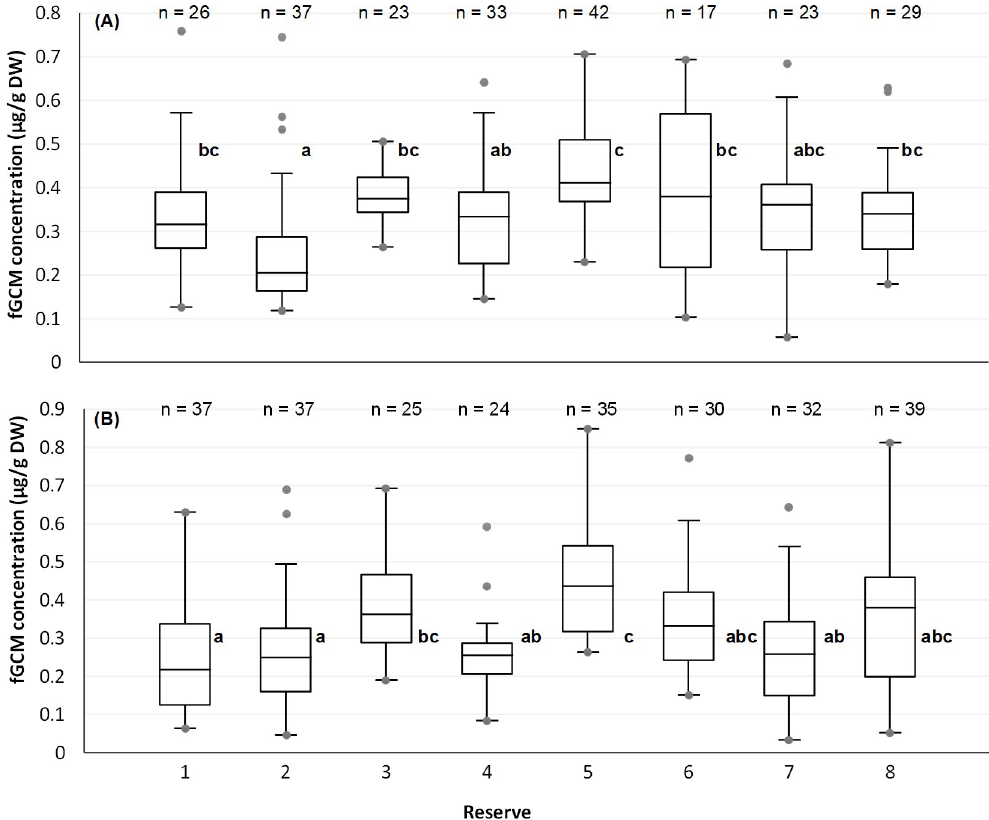
Fig 2. Influence of reserve on the faecal glucocorticoid metabolite (fGCM) concentration ( μ g/g DW) collected for (A) Female, and (B) Male elephants from eight reserves between March 2019 and January 2021. Different letters indicate significant differences between elephants of respective reserves (based on mean ranks, a = reserve with the lowest mean rank). The graph represents the minimum, 1st quartile, median, and 3rd quartile, together with both the limits (the ends of the "whiskers") beyond which values are considered anomalous. The limits were calculated as follows: Lower limit = Q1–1.5 (Q3—Q1); Upper limit = Q3 + 1.5 (Q3—Q1).